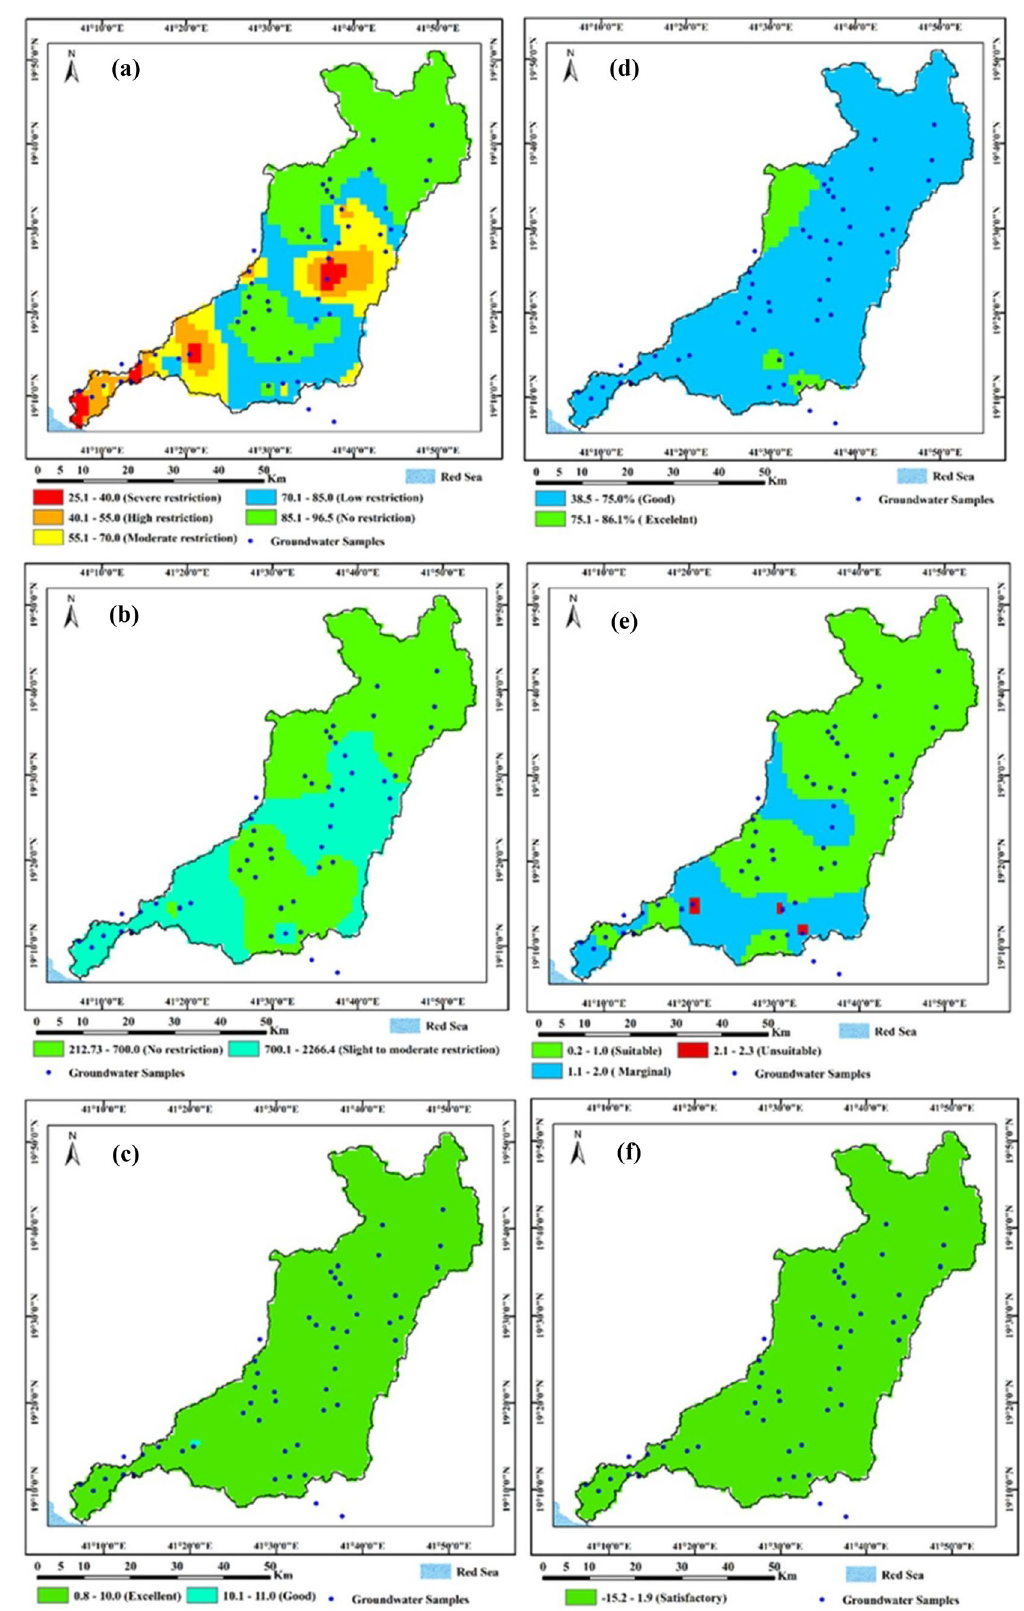
Fig. 9 Spatial distribution maps of IWQIs in Wadi Qanunah basin: a IWQI, b TDS, c SAR, d PS, e MH, and f